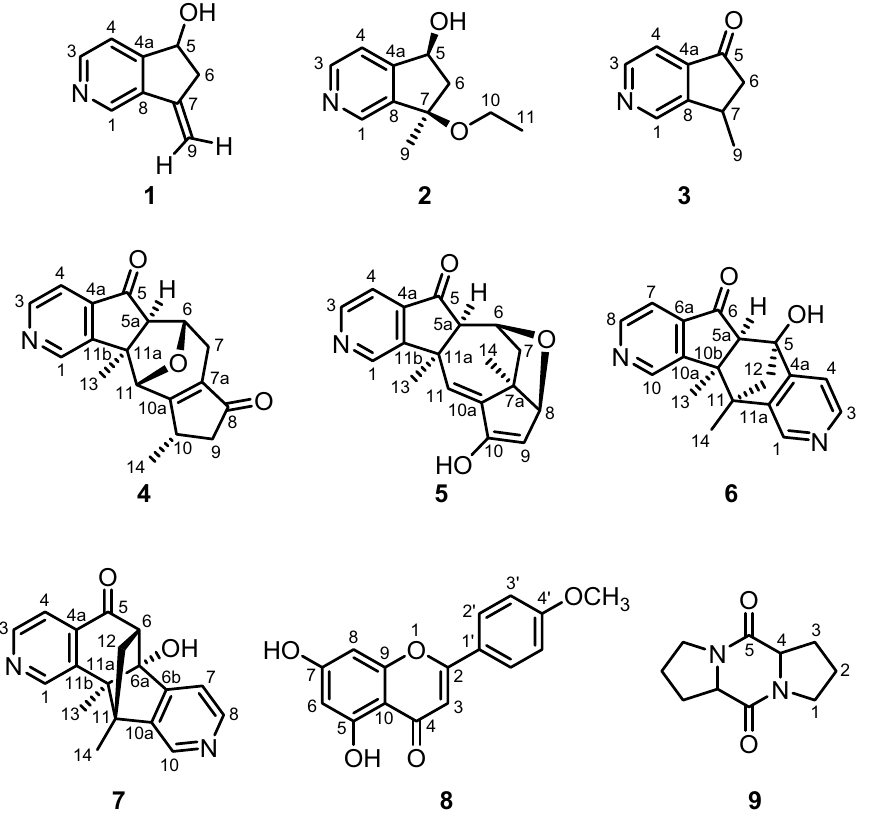
Figure 1. Structures of the compounds 1–9 isolated from the aerial parts of C.